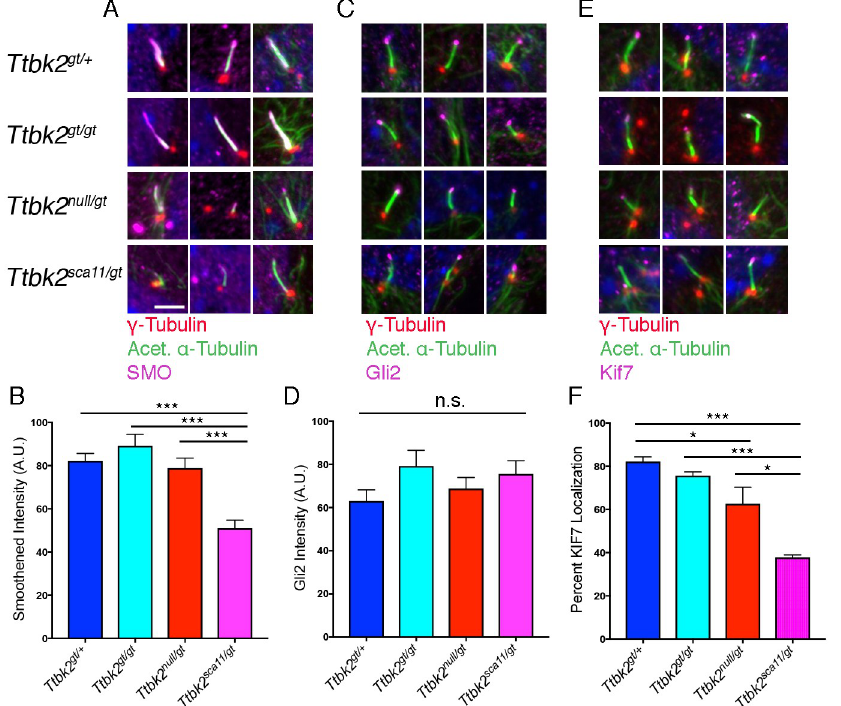
Fig 6. Localization of key HH signaling proteins is impaired in Ttbk2 sca11/gt cilia. (A, B) SMO localization in heterozygous and Ttbk2 mutant MEFs. Immunostaining for SMO (magenta) is shown for each of the indicated genotypes in (A), with centrosomes stained for γ -Tubulin (red), and the ciliary axoneme labeled with Acetylated α - Tubulin (green). Cells were serum starved for 24 hours before being treated with 200nm SAG for an additional 24 hours. Two representative images are shown. (B) depicts a quantification of pixel intensity of SMO within the ciliary axoneme of each genotype upon stimulation with SAG. Bars represent the mean intensity of 50 measurements across 3 replicates for each genotype. Error bars depict SEM. Statistical comparison was performed by 1-way ANOVA with Tukey-Kramer post-hoc test. Ttbk2 sca11/gt cells display reduced SMO intensity within the cilium compared with each of the other genotypes (p < 0.0001 vs Ttbk2 gt/+ and Ttbk2 gt/gt ; p = 0.0003 vs Ttbk2 null/gt ). (C,D) Localization of GLI2 (magenta) to the ciliary tip in MEFs of each indicated genotype. In (C) cells are counterstained for γ -Tubulin (red) to label centrosomes and Acetylated α -Tubulin (green) to label the axonemes. Three representative images are shown for each genotype. Quantification of pixel intensity of GLI2 at the ciliary tip of each genotype is shown in (D). (E,F) Localization of KIF7 (magenta) to the ciliary tip in MEFs of each indicated genotype. In (E) cells are counterstained for γ -Tubulin (red) to label centrosomes and Acetylated α -Tubulin (green) to label the axonemes. Three representative images are shown for each genotype. The percentage of cilia with KIF7 localized to the ciliary tip upon treatment with SAG is shown in (F). We find that the frequency of KIF7 localization is reduced in Ttbk2 sca11/gt cells compared with other genotypes (1-way ANOVA, p = 0.0003 vs Ttbk2 gt/+ ; p = 0.0009 vs Ttbk2 gt/gt ; p = 0.012 vs Ttbk2 null/gt .) n = 50 cilia pooled from 3 biological replicates. Scale bar = 5 μ